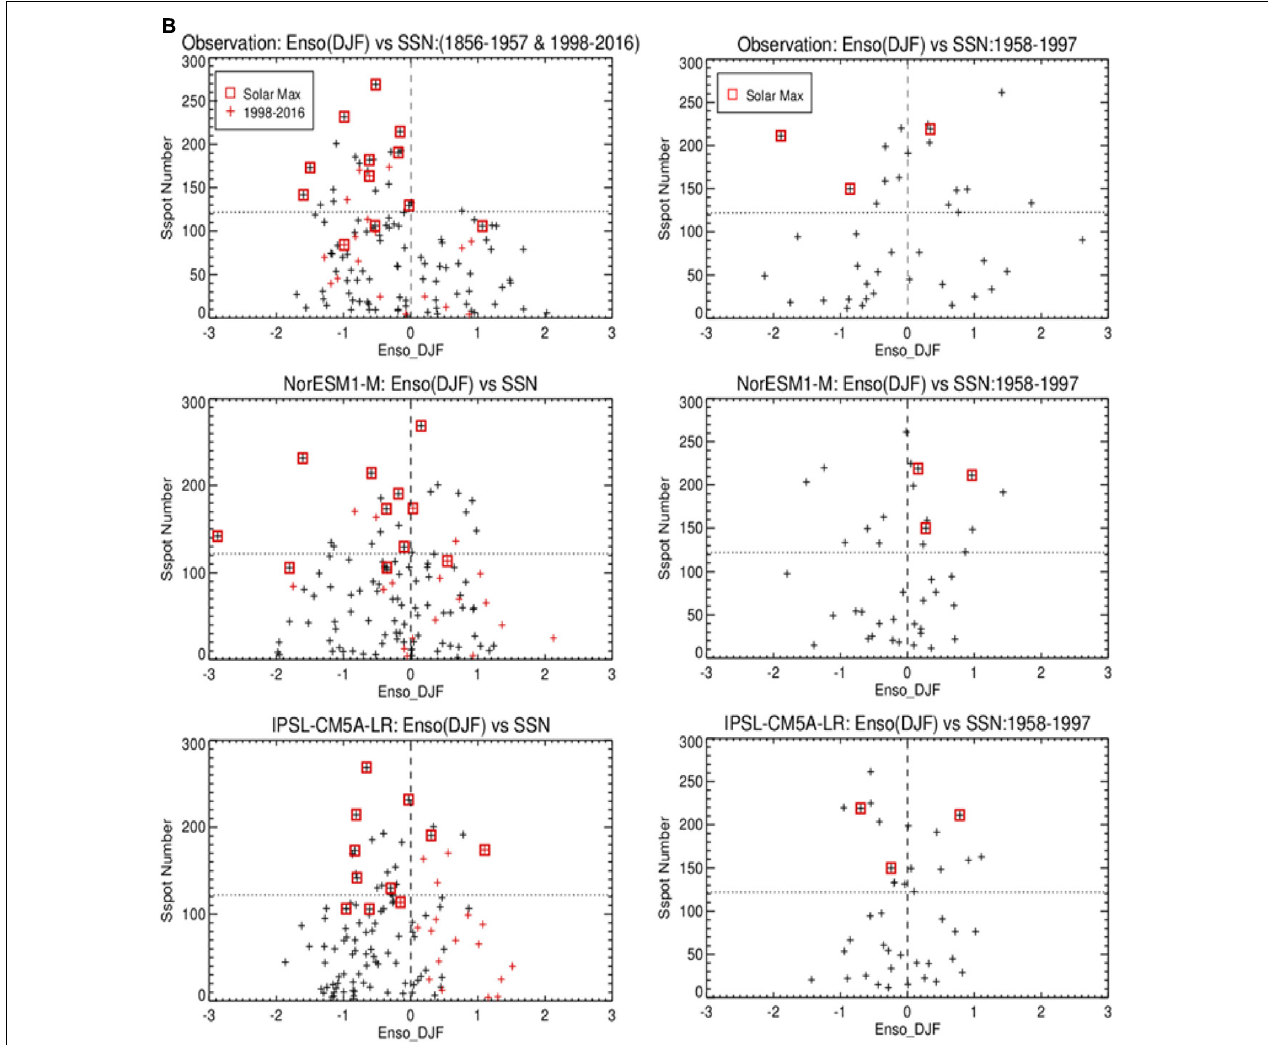
FIGURE 10 | Average ENSO (Dec-Jan-Feb) against annual average Sunspot number (SSN). Observed Niño 3.4 index is used in the top row of each plot, while bottom two rows use Niño 3.4 temperature for CMIP5 models NorESM1-M and IPSL-CM5A-LR, respectively. In (A) it considers the whole period of observed record (1856–2016) and in (B) it separates out an intervening period (1958–1997) from the whole set of observation. The right panel in (B) is for period ‘1958–1997’ and the left for ‘1856–1957 and